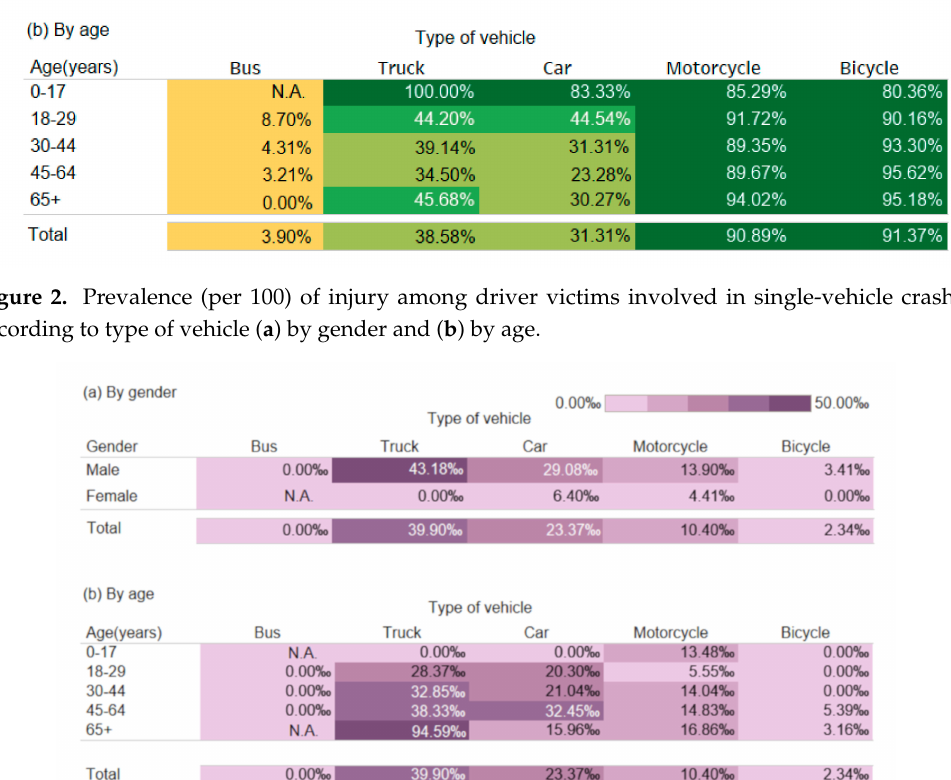
Figure 3. Fatality rate (per 1000) among injured driver victims involved in single-vehicle crashes according to vehicle type ( a ) by gender and ( b ) by age; N.A.: Not